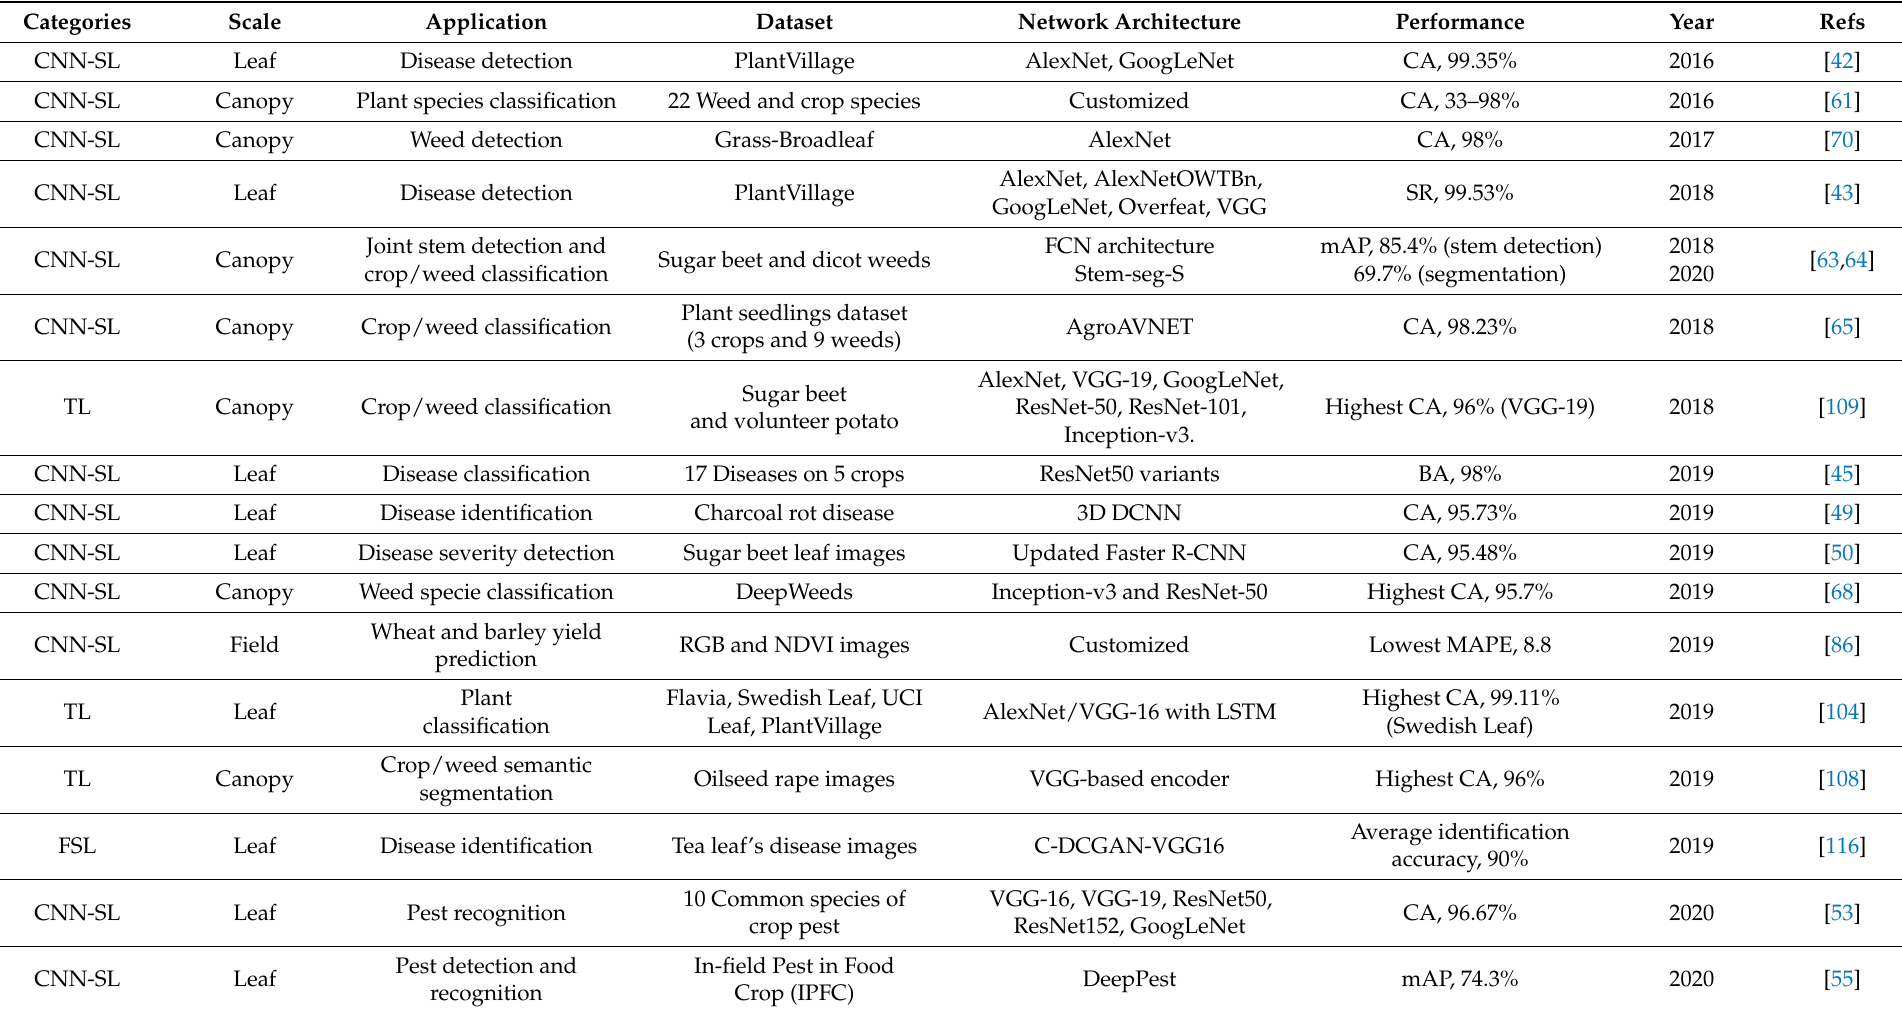
Table 1. Examples of DL applications in PA following the